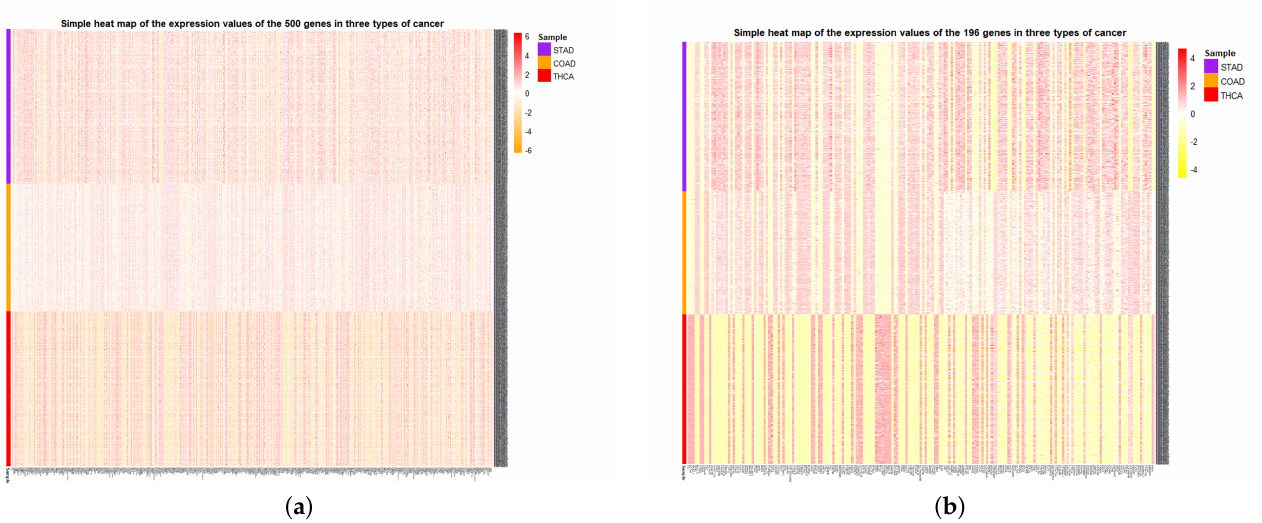
Figure 9. Simple heat map of gene expression for the selected genes in identifying multiple subtypes. ( a ) Simple heat map of 500 genes selected by pseudo-f statistics. ( b ) Simple heat map of the 196 genes selected by network module mining.